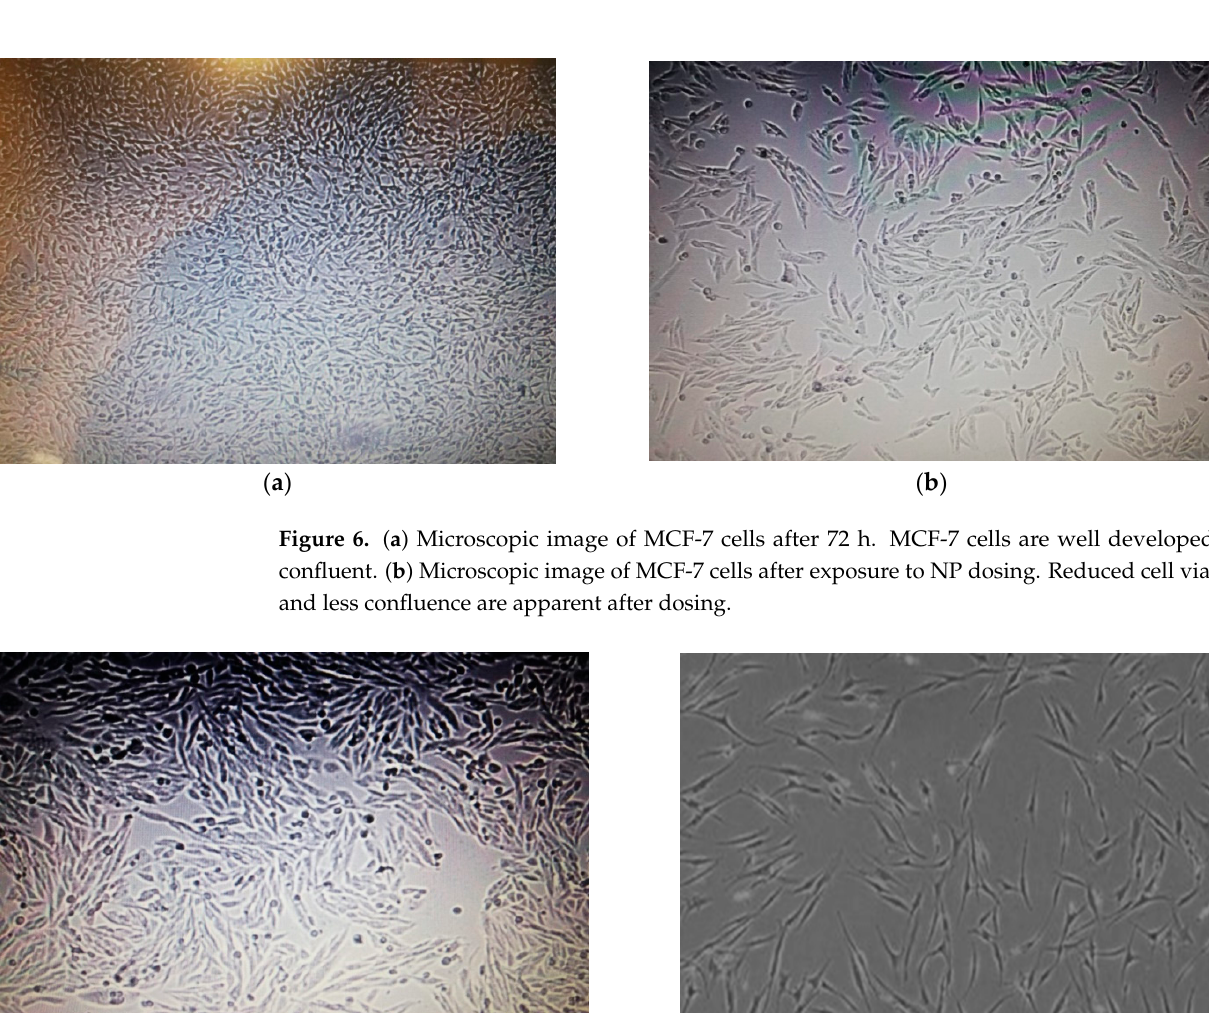
Figure 5. Cytotoxic effect of biosynthesized silver nanoparticles (AgNPs) and M. oleifera extract (MOE) on cell viability of HUVEC cell line.